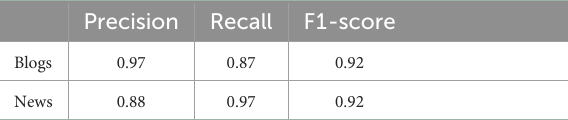
TABLE 7 Model performance of the SVMs on the new texts ( N = 200) extracted from CORE. Precision Recall F1-score Blogs 0.97 0.87